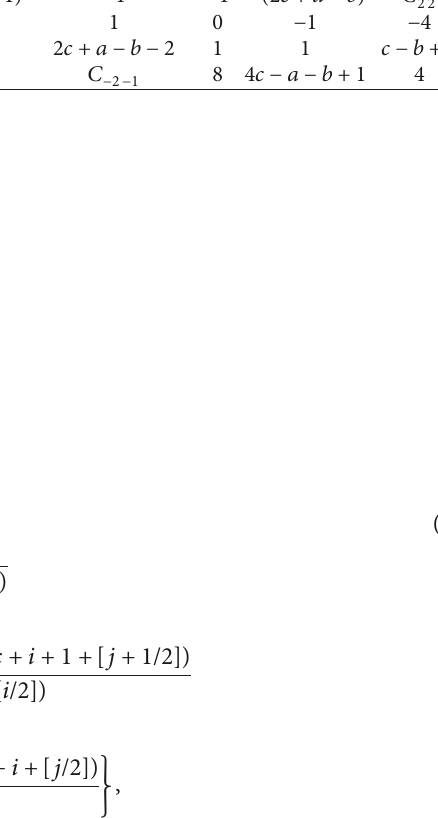
Table 2: Table for the coefficients B